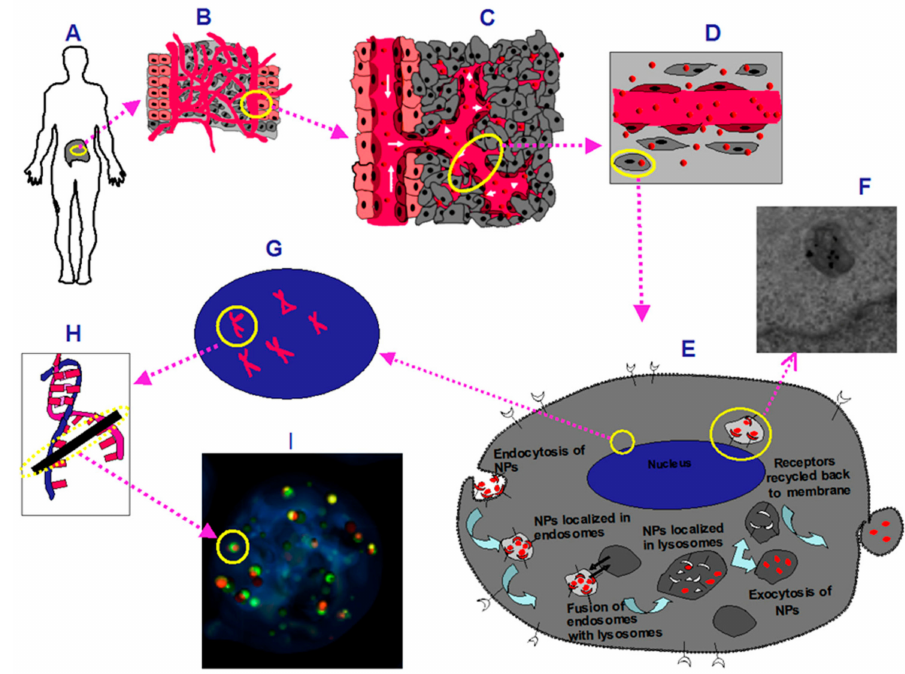
Figure 1. A schematic of gold nanoparticle (GNP) accumulation from vasculature to cell level ( A ) A diagram representing a pancreatic tumor; ( B ) Tumor microenvironment; ( C ) Abnormal tumor vasculature; ( D ) GNPs (represented as red spheres) leaking through tumor vessels; ( E ) A diagram that represents one of the GNP cell uptake pathways.; ( F ) Transmission Electron Microscopy (TEM) images of GNPs in a vesicle close to the nucleus of a cell; ( G ) Enlarged schematic of the nucleus with DNA represented as double helices; ( H ) A double strand break in the DNA is represented. One of the major targets and mechanisms of radiation and many chemotherapeutic agents is to kill cancer cells through DNA breaks; ( I ) Markers that probe for DNA double strand breaks